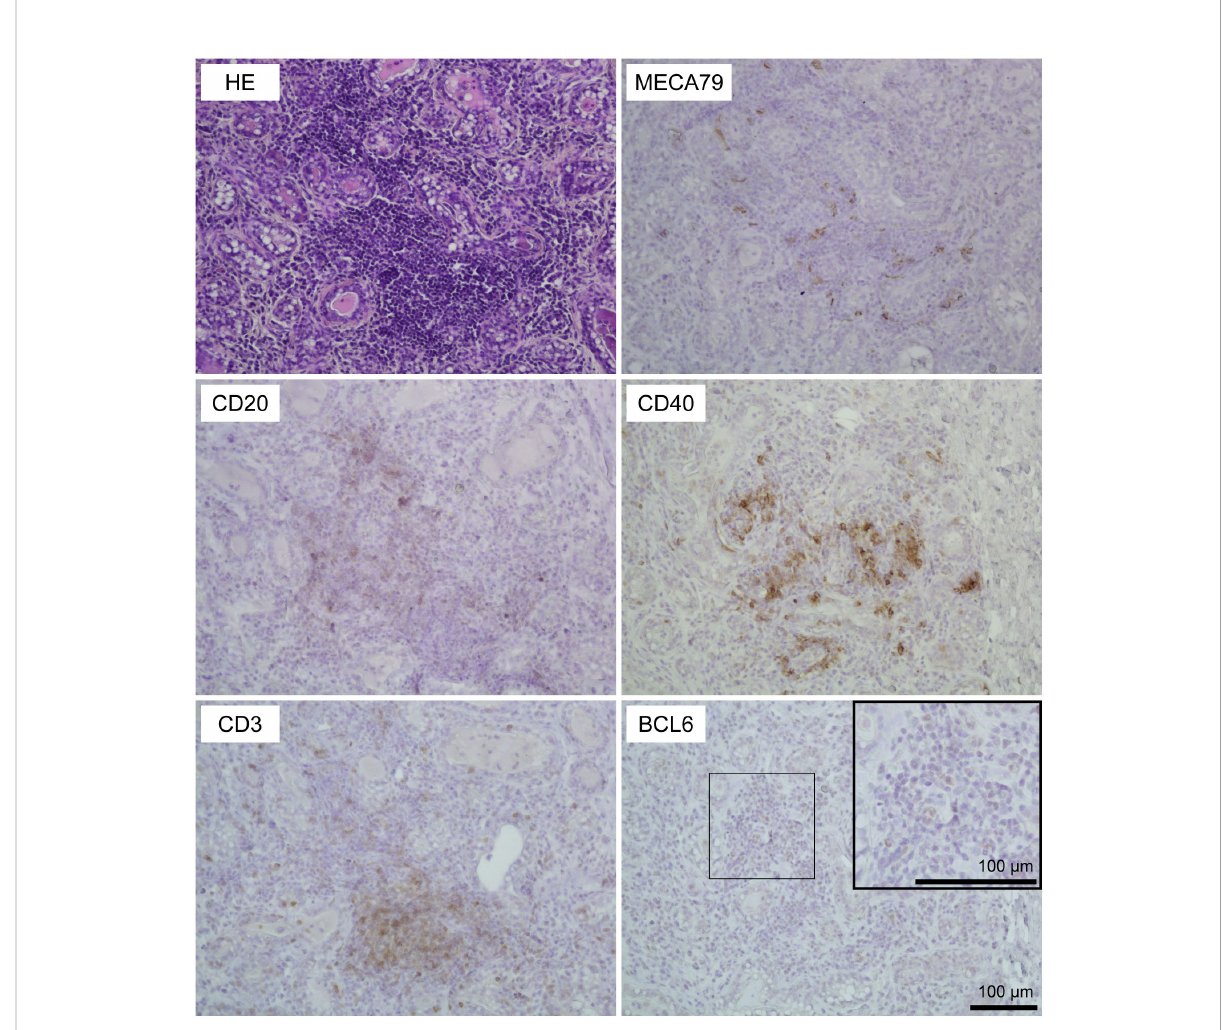
FIGURE 2 Representative images of hematoxylin and eosin staining (HE) staining and immunohistochemistry against CD20 (B cells), CD3 (T cells), MECA79 (high endothelial venules; HEVs), CD40 (follicular dendritic cells), and BCL6 (germinal center) in a large-sized aggregation of lymphocytes in goat mammary glands. Images of the same position are shown. Scale bar, 100 m